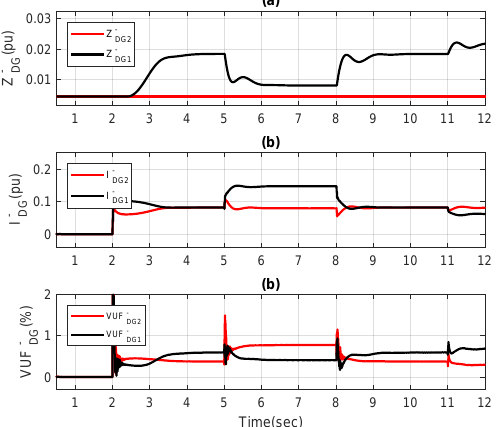
Figure 18. Negative-sequence ( a ) output impedance, ( b ) current, and ( c ) VUF of DG